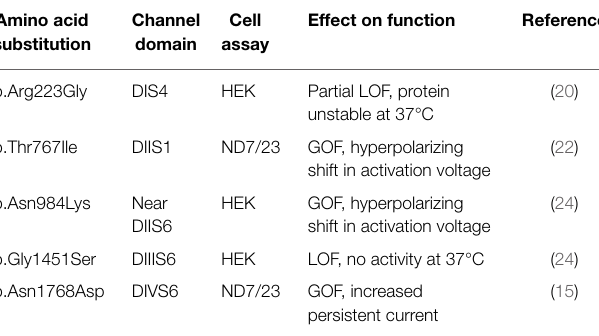
TABLE 4 | Functional effects of five SCN8A mutations in patients with epileptic encephalopathy . Amino acid Channel Cell Effect on function substitution domain assay